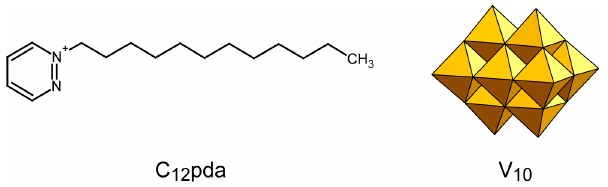
Figure 1. Molecular structures of dodecylpyridazinium (C 12 pda) cation ( left ) and decavanadate (V 10 ) anion ( right ).